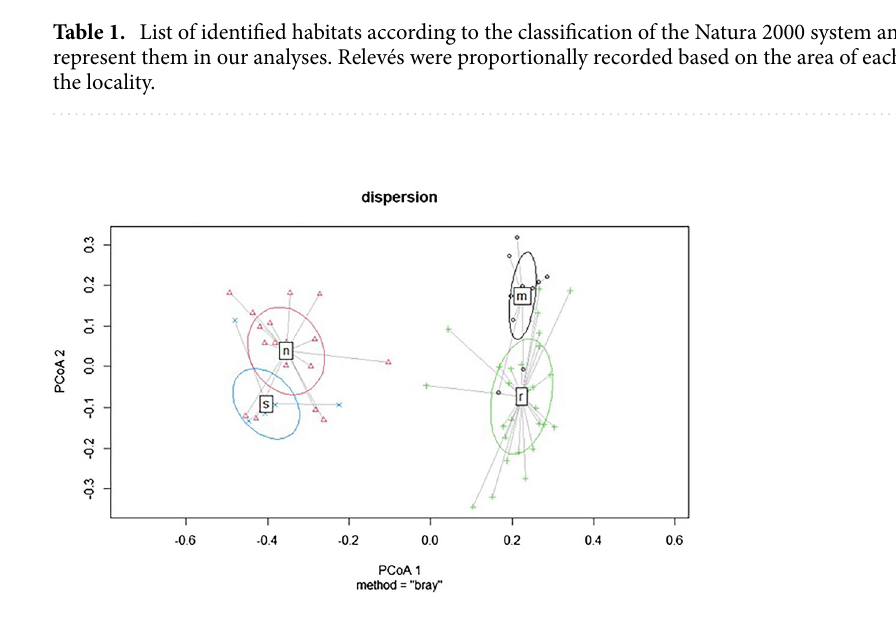
Figure 3. A significant differentiation of grouped relevés based on species composition showing relationships between target habitats. Abbreviations: s – 9410 – Acidophilous Picea forests of the montane to alpine levels , n